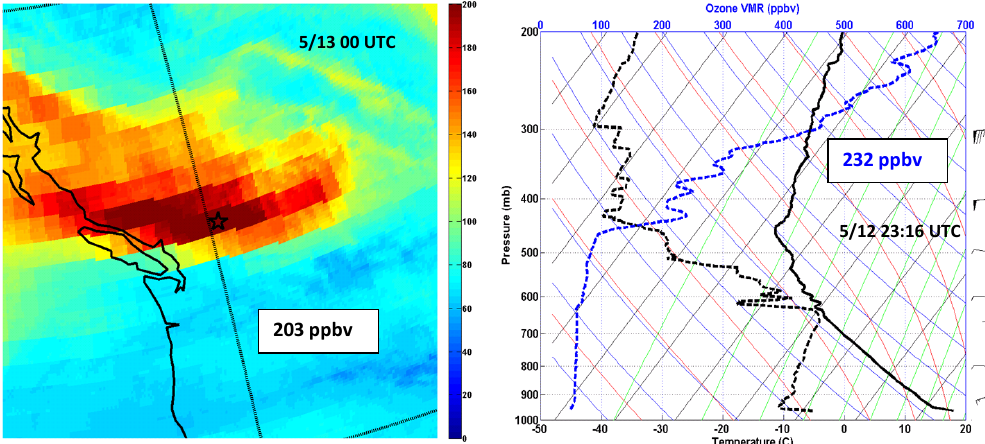
Fig. 9. Images from Kelowna, BC ozonesonde launch on 12 May 2006. (a) The zoomed MUTOP image shows the location of the Kelowna ozonesonde site (black star) within and UT trough ozone enhancement for 13 May 00:00UTC (a zoomed version of Fig. 1b). The color bar represents estimated layer-average UT ozone VMR inppbv, with 203ppbv predicted by MUTOP. (b) The attached Skew-T plot is from the 12 May ozonesonde launch and displays column temperature (black solid), dewpoint temperature (black dashed), and ozone VMR (blue dashed), with 232ppbv observed as the layer